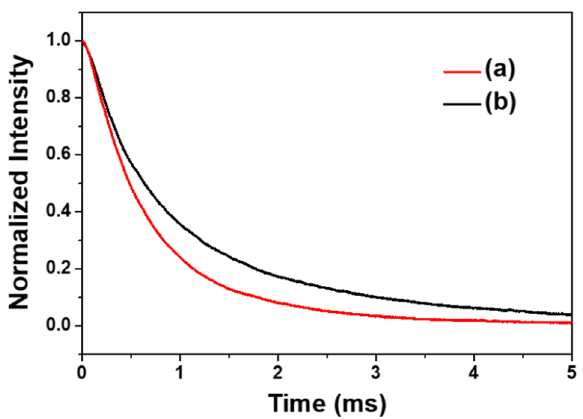
Figure 5. Vacuum UV (VUV) luminescence decay curve of YVO 4 :Eu 3+ nanophosphors with different solution acidity. (a) pH = 7 and (b) pH =10.